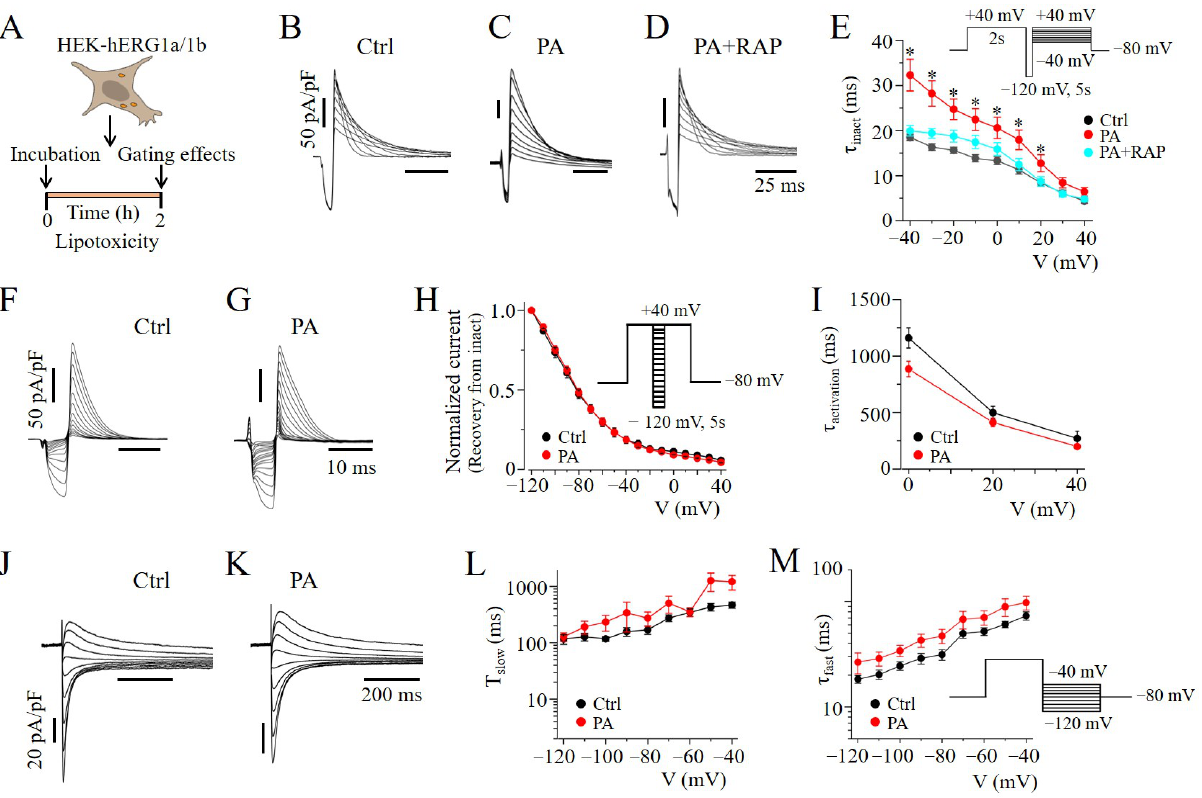
Figure 5. Rapamycin affects hERG1a/1b channel inactivation in lipotoxic HEK293 cells. ( A ) Ex- perimental protocol: hERG1a/1b channel gating mechanisms were determined in HEK293 cells under control conditions, and after pre-exposure to lipotoxicity for 2 h, using the illustrated voltage protocols. Exemplar current traces ( B – D ) and a graph of τ inactivation ( E ) measured under the